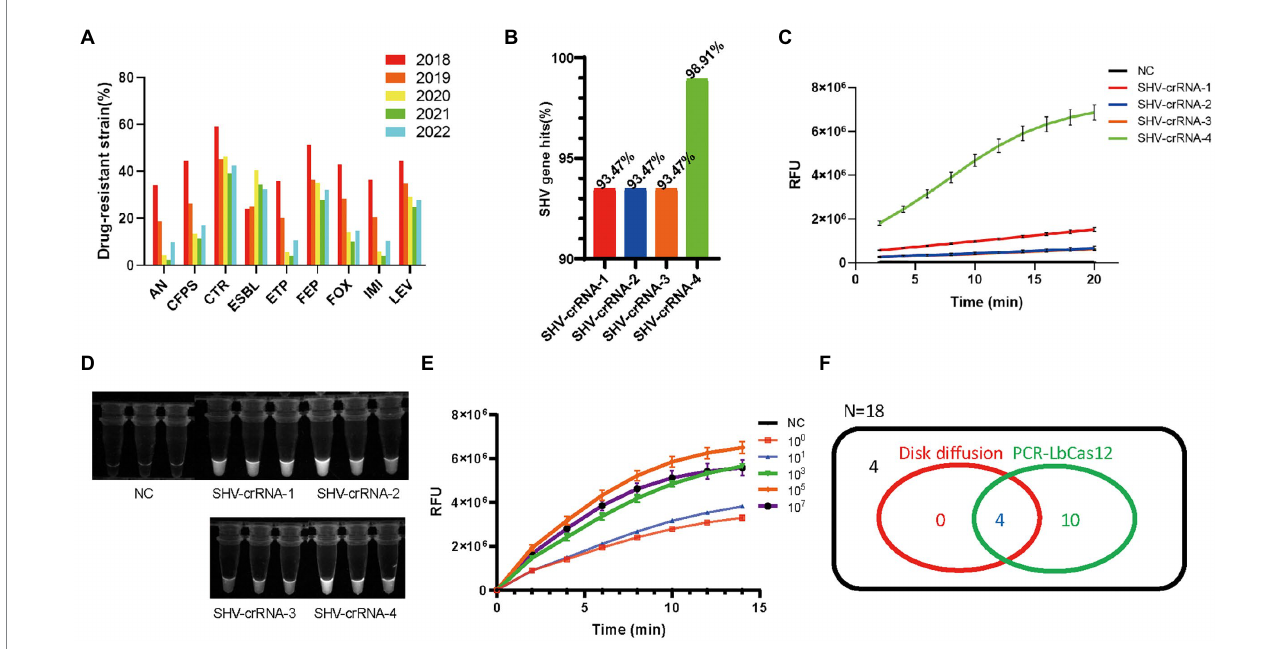
FIGURE 3 (A) The summary of drug-resistant Klebsiella pneumonia information in the Medical Laboratory Department of Shenzhen Luohu People’s Hospital from January 2018 to June 2022. (B) The percentage of SHV genes hit by four SHV-crRNAs. FAM signal, (C) and photograph under UV, (D) of four